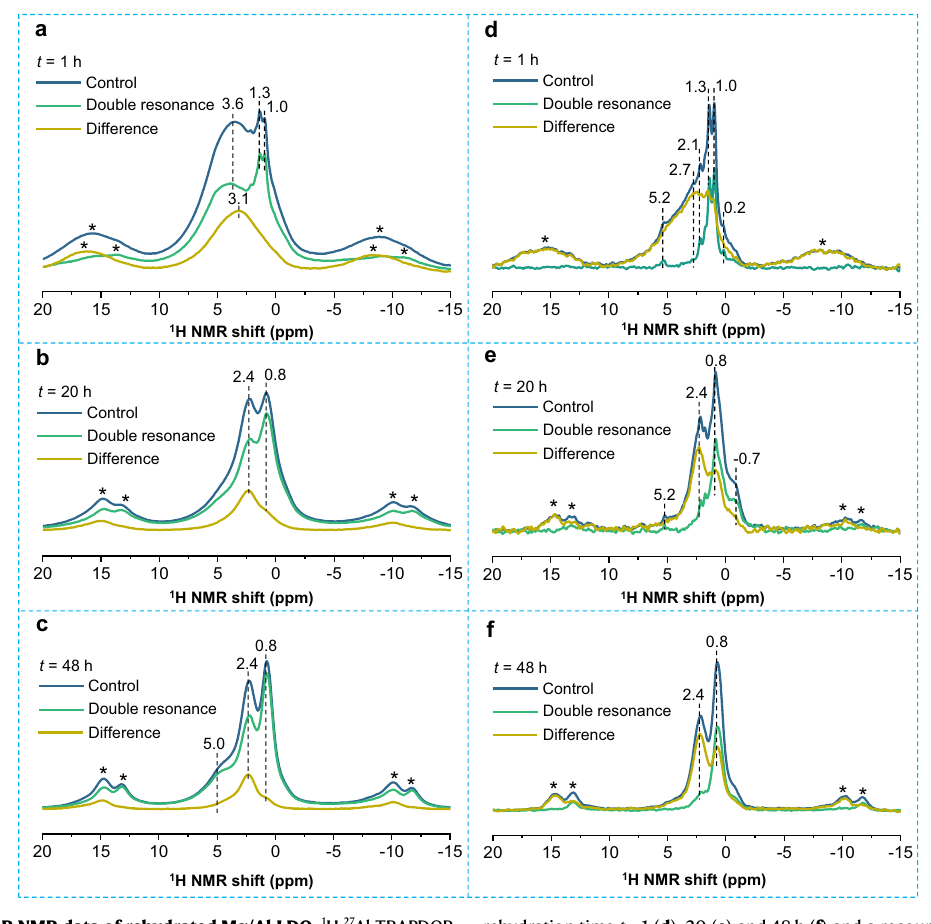
rehydration time t =1 ( d ), 20 ( e ) and 48h ( f ) and a recoupling time of 2ms.